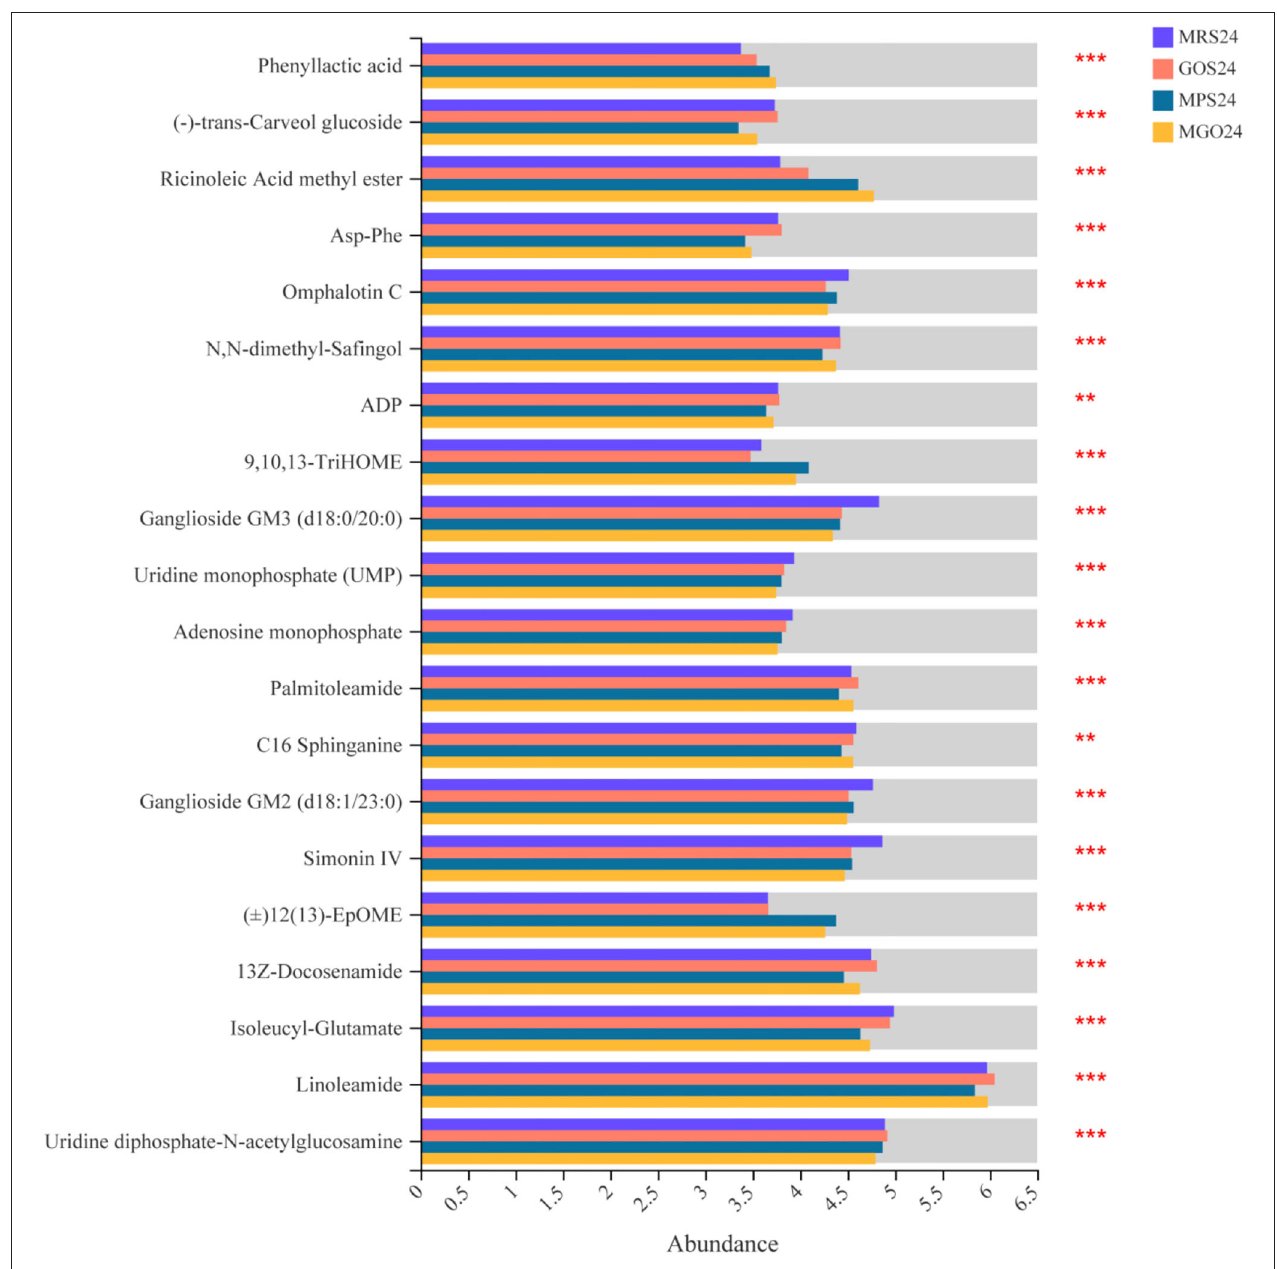
FIGURE 6 | Comparative differential metabolites analyses of LGG cultured with different prebiotics for 24h. The horizontal coordinates represent the average relative abundance of metabolites in different groups, and the vertical coordinates represent metabolites. ** 0.001 < P ≤ 0.01 , *** P ≤ 0.001 .